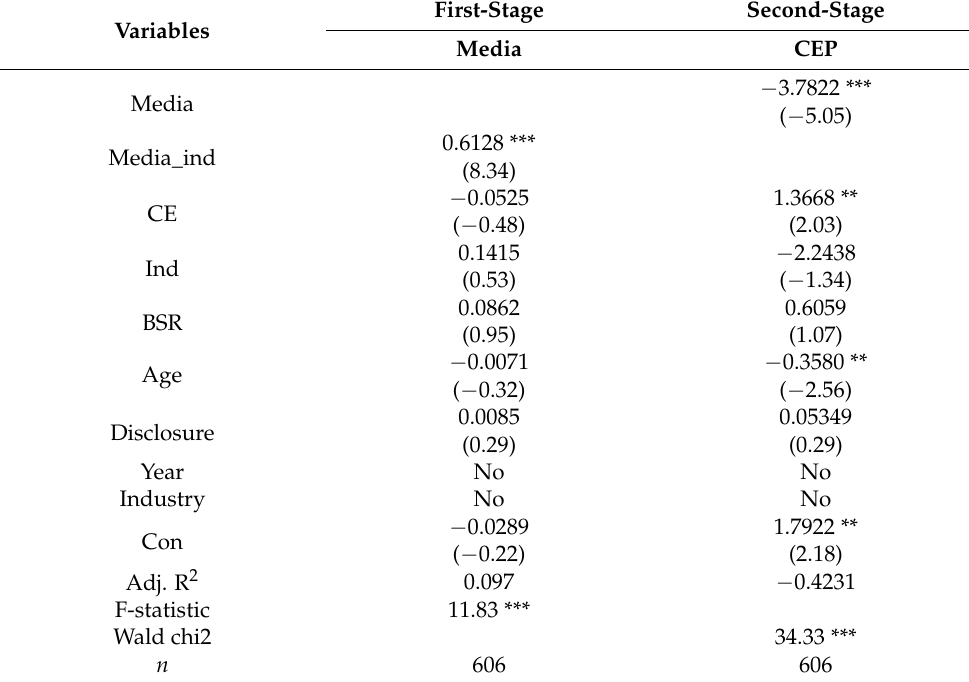
Table 8. Endogenous test